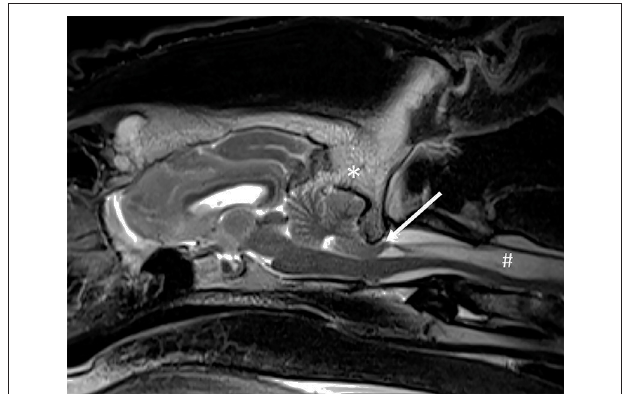
FIGURE 2 | Chiari-like malformation in a lion. On this T2-W sagittal image there is thickening of the occipital bone and osseous tentorium of the cerebellum (*), crowding of the caudal fossa, cerebellar compression and herniation (arrow), and marked syringomyelia of the cranial cervical spinal cord